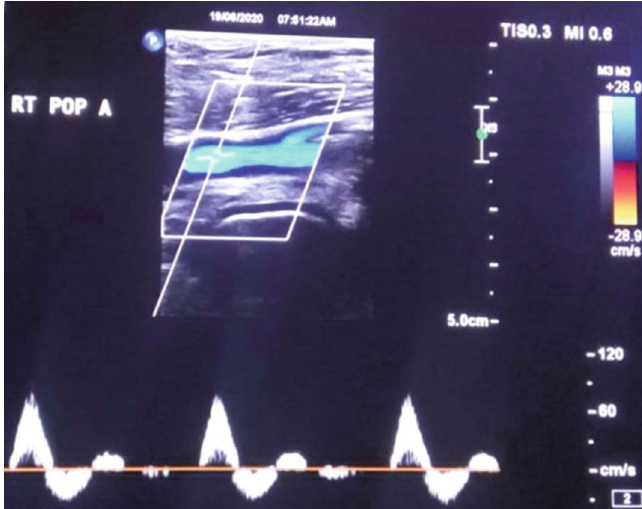
Figure 3: Duplex scan of the right popliteal artery at 12-month follow-up, showing normal triphasic fl